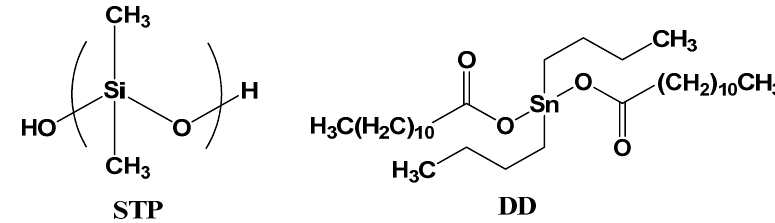
Figure 1. Chemical structures of silanol-terminated polydimethylsiloxane (STP) as a healing agent and dibutyltin dilaurate (DD) as a catalyst.